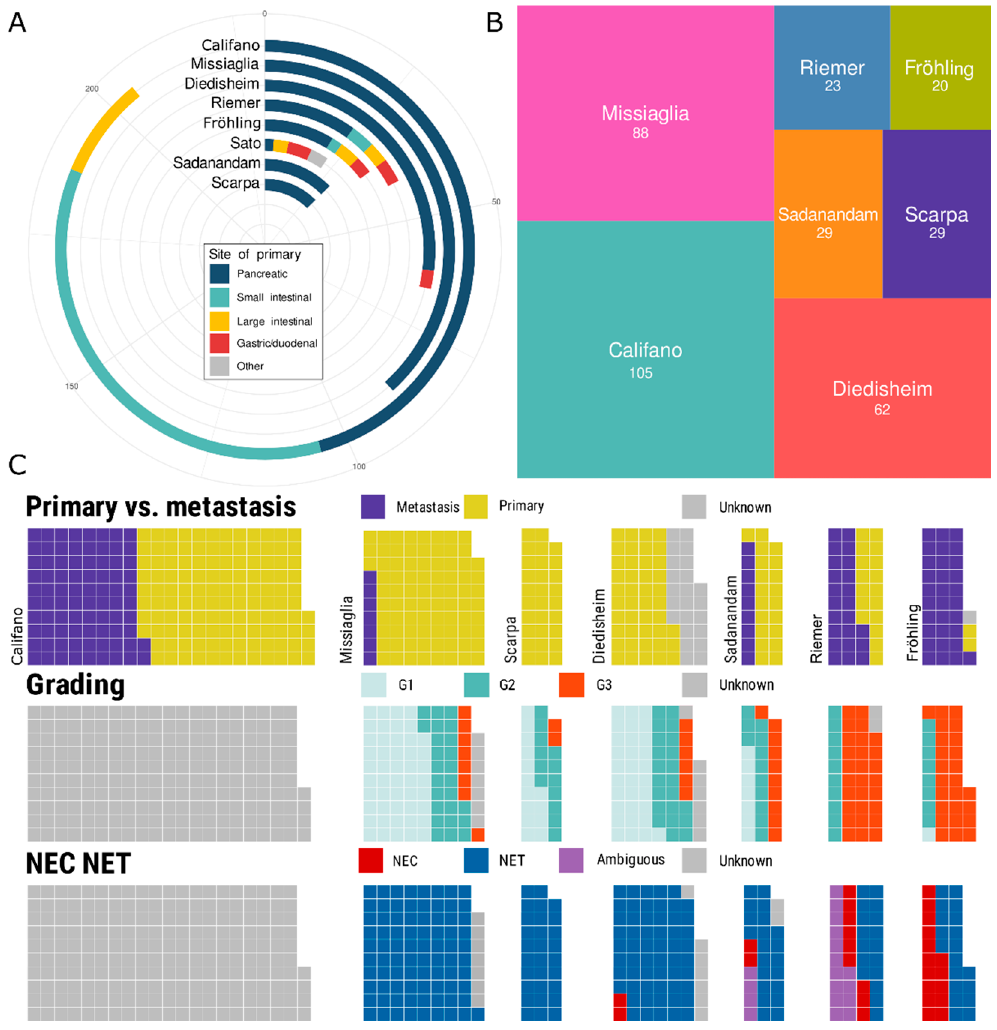
Figure 2. Overview of the benchmarked pancreatic and non-pancreatic NEN datasets. ( A ): Stratification with respect to the site of the primaries of the benchmarked 513 pancreatic and non-pancreatic NEN from eight studies. ( B ): Relative and absolute contributions of the seven panNEN datasets with respect to the set of 356 benchmarked panNENs. ( C ): Available metadata annotation for the seven panNEN datasets. Primary versus metastasis annotation is widely available while grading and NEC versus NET status are less frequently available while pancreatic NECs are provided by four